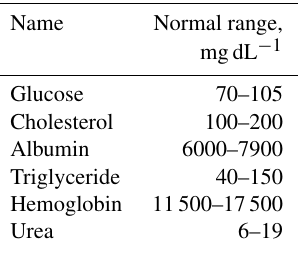
Table 2. Typical range of important interfering blood components for capacitance spectroscopy of